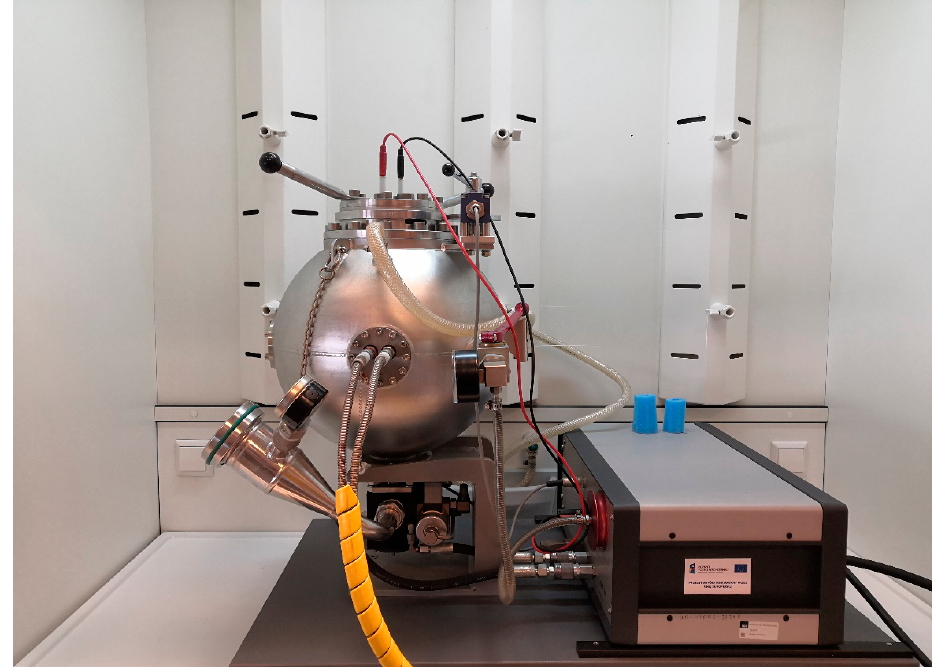
Figure 4. KSEP 310 explosivity analyzer.